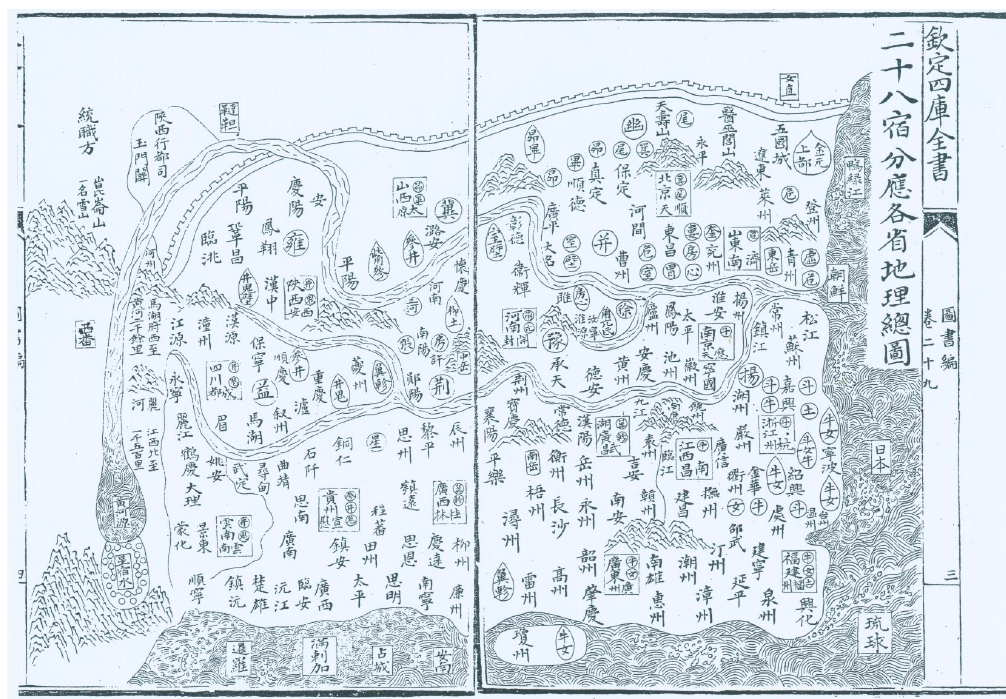
Figure 1. The “star fields” projected on a Ming dynasty map of China. (Zhang, Huang 章 潢 . Tushu bian 圖 書 編 . In Wenyuange siku quan shu 972, juan 29, 3b-4a. Taipei: Taiwan Shangwu Yinshu,